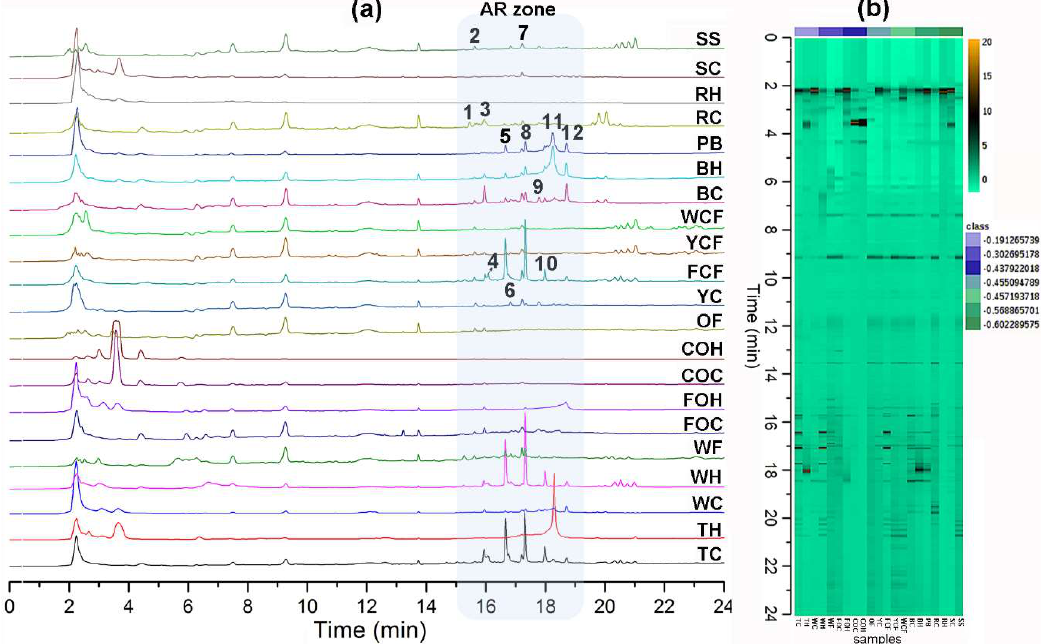
Figure 1. ( a ) Liquid Chromatography coupled to electrospray ionization mass spectrometry (LC-ESIMS) profiles; samples abbreviation according to Table 2; n -alkyl(enyl)resorcinols (AR) zone within chromatogram is highlighted in light blue box; bold numbers indicate the annotated AR according to Table 3; ( b ) LC-ESIMS data-derived heatmap using the Ward clustering algorithm and Euclidean distances; spots correspond to each detected compound by LC-ESIMS in the negative ion mode.